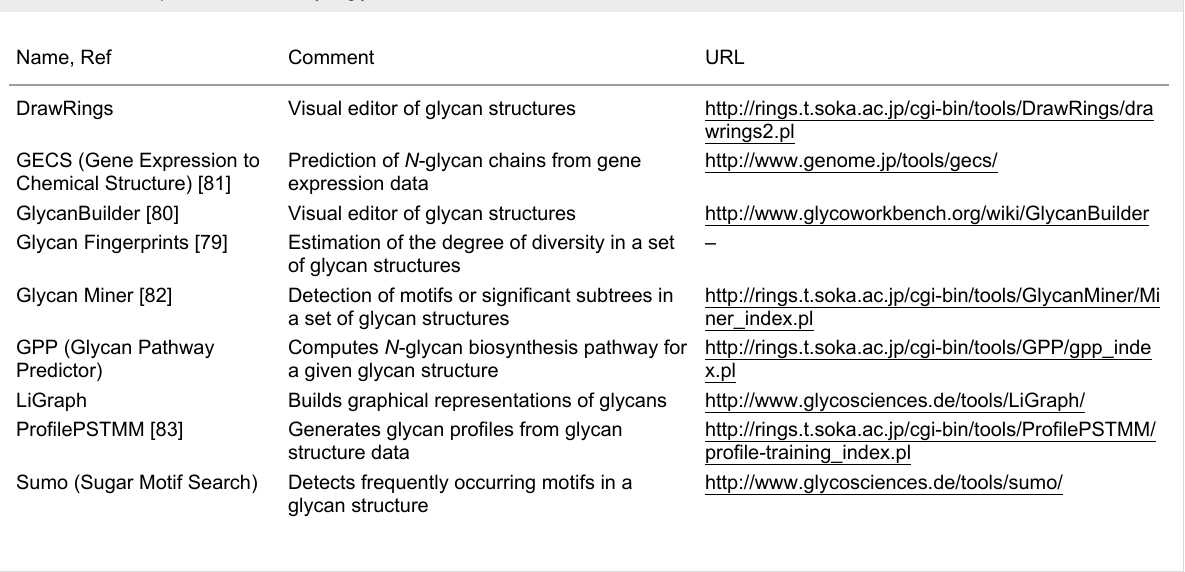
Table 3: Tools to input, convert, or analyze glycan